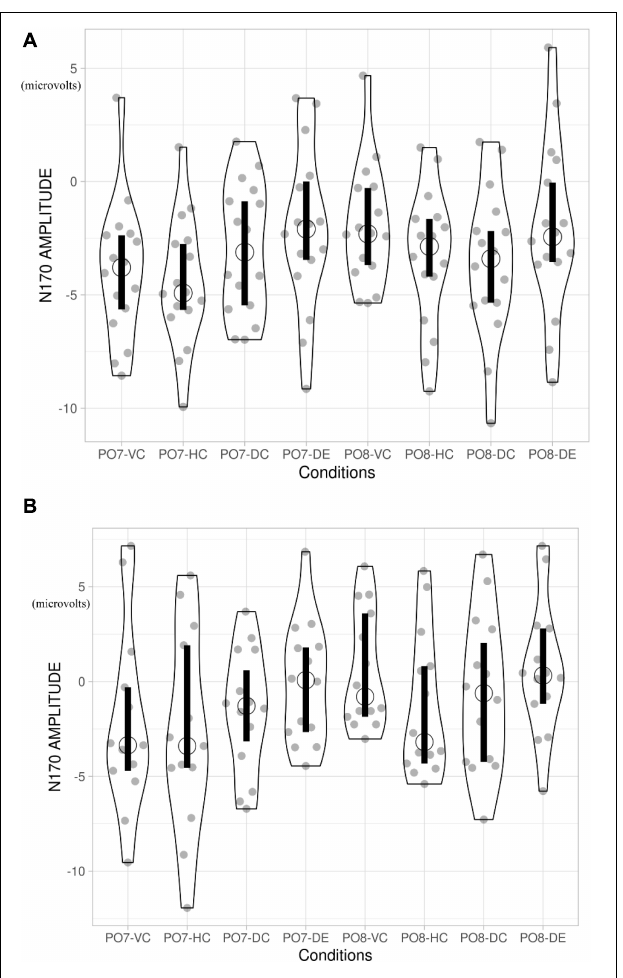
FIGURE 5 | (A) N170 amplitude of adults. Open circle indicates the median of the data. Vertical bar indicates the 95% confidence interval for each median determined by bootstrapping. VC, viewing Chinese; HC, handwriting Chinese; DC, drawing followed by Chinese recognition; DE, drawing followed by English recognition. (B) N170 amplitude of children. Open circle indicates the median of the data. Vertical bar indicates the 95% confidence interval for each median determined by